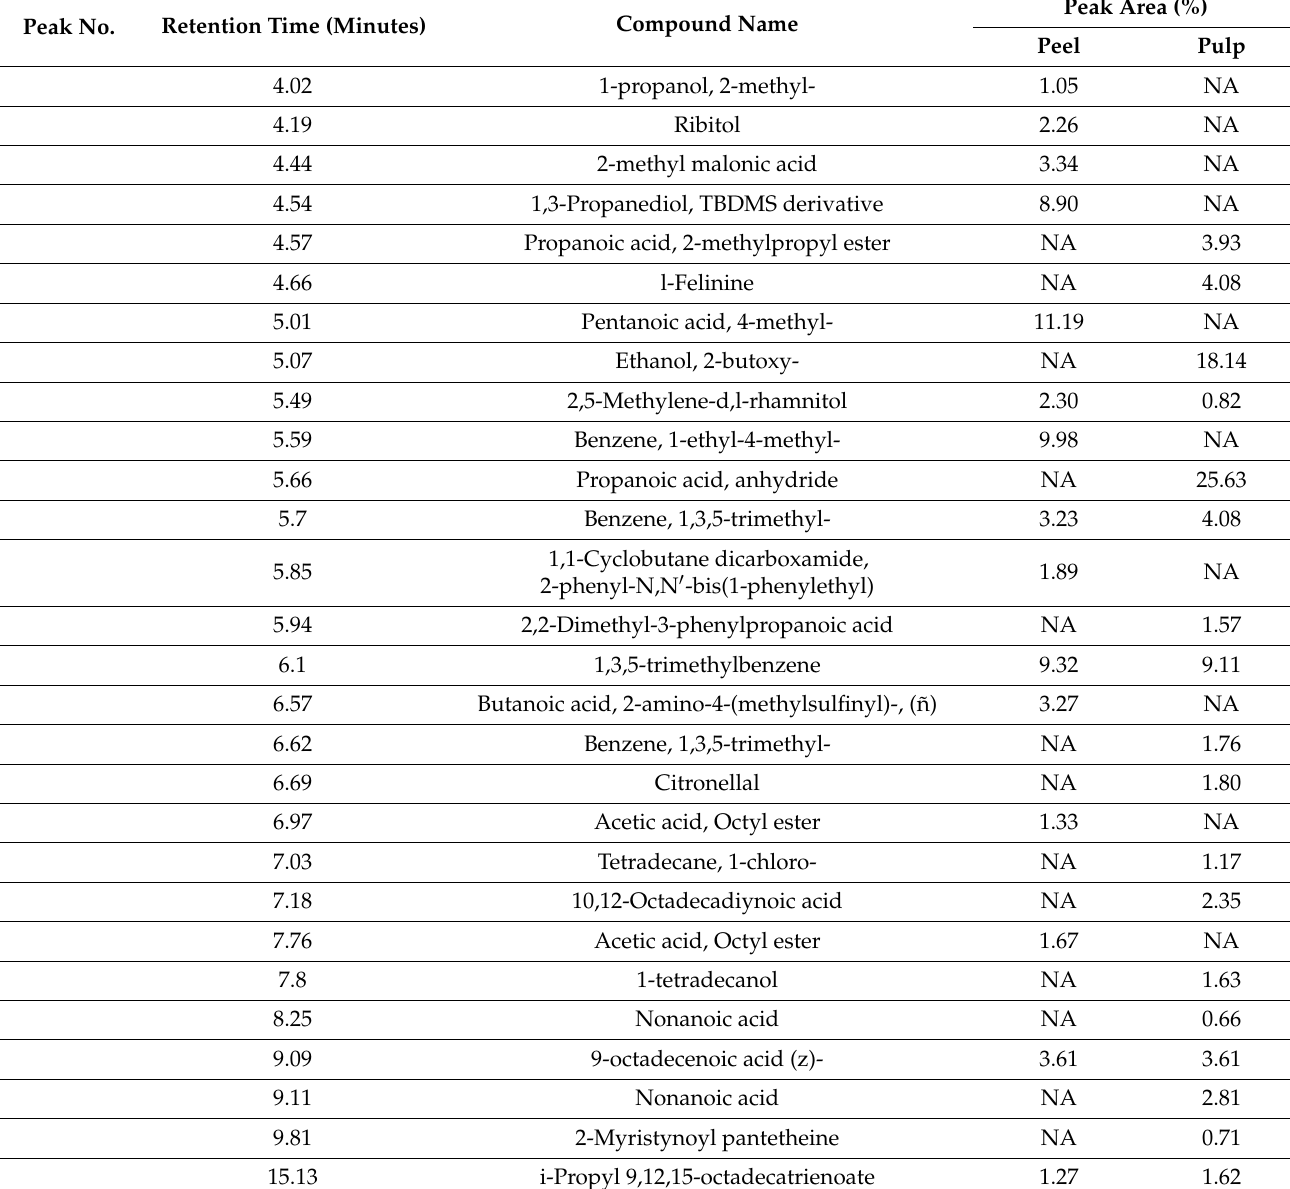
(Table 2). Interestingly, the most prevalent compound in the peel extract was 9-octadecenoic acid (Z), with a retention time of 26.95 min and a peak area of 13.22%. Propanoic acid anhydride was the most dominant compound in the peel extract, with a retention time of 5.66 min and a peak area of 25.36%. The peel and pulp extracts of H. undatus share only nine similar phytocompounds in convergent percentages. The most prevalent compounds are 9-octadecenoic acid (Z)—(peel: 13.22%, pulp: 8.85%)—and 1,3,5-trimethylbenzene (peel: 9.32%, pulp: 9.11%). The mass spectrometry of the peel extract revealed 13 compounds that were not detected in the pulp extract. The most dominant were 4-methylpentanoic acid (11.19%), 1-ethyl-4-methylbenzene (9.98%), and 1,3-propanediol, TBDMS derivative (8.9%). The GC analysis also indicated that fourteen compounds identified in the mass spectrum of the pulp extract were not found in the mass spectrum of the peel extract. The most dominant were propanoic acid, anhydride (25.63%), and 2-butoxyethanol (18.14%). Table 2. Phytocomponents identified by the GC-MS analysis in the peel and pulp extracts of H. undatus . Peak